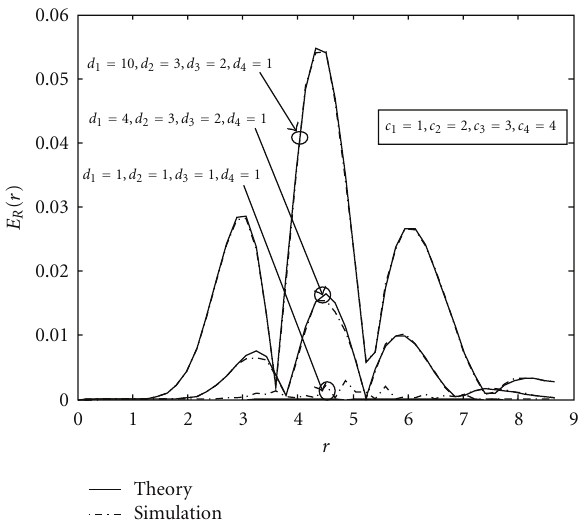
Figure 6: Comparison of the absolute error of Nakagami